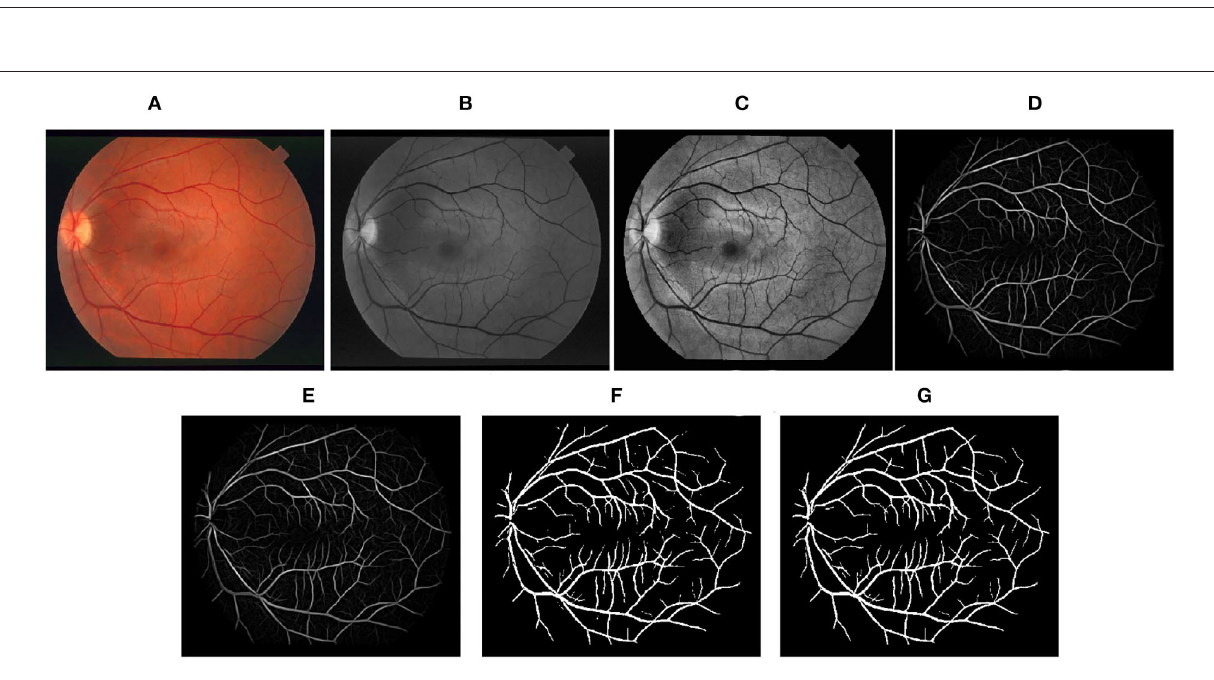
FIGURE 4 | Stepwise illustration of the proposed method. (A) Color retinal fundus image from STARE database. (B) Green channel retinal fundus image. (C) Processing diagram after CLAHE. (D) Processing diagram after B-COSFIRE filters. (E) Processing diagram after morphological filters. (F) Processing diagram after binary threshold. (G) Final segmented